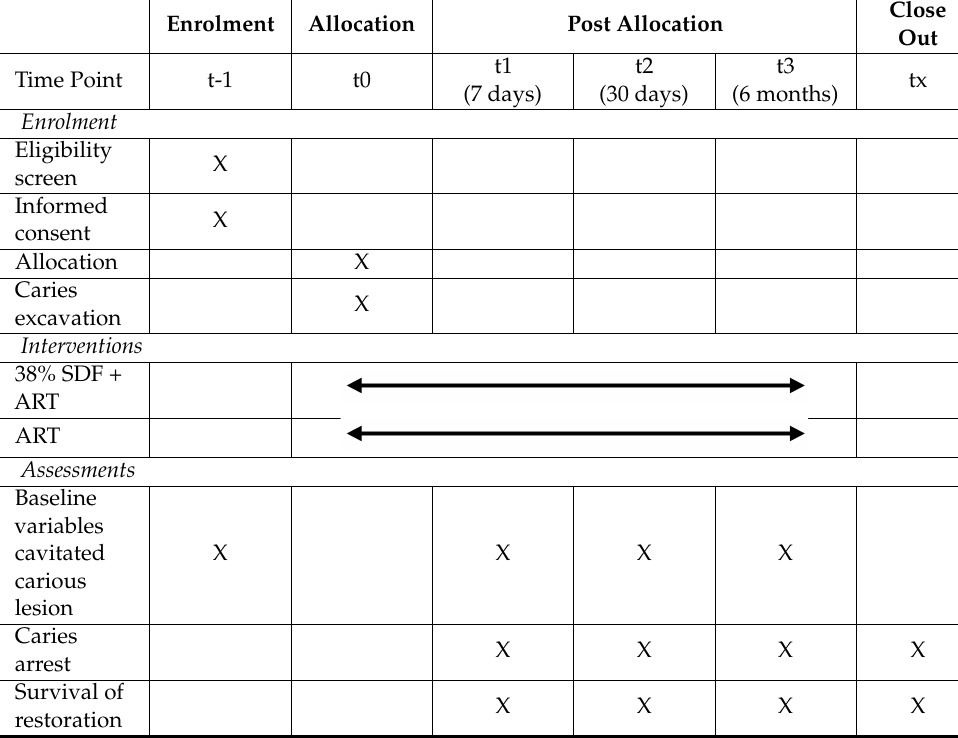
Table 1. Participant